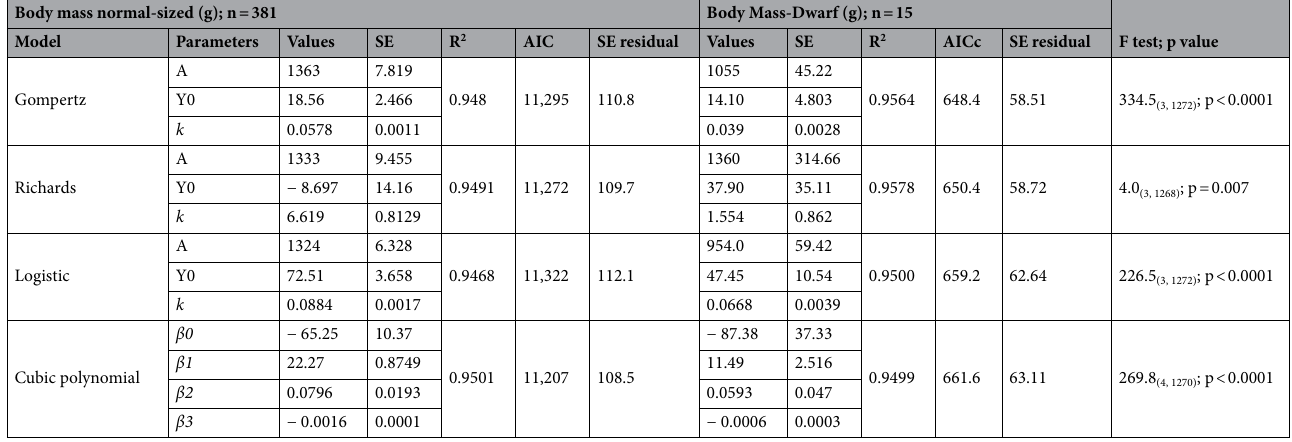
Table 1. Results from four models fitted to body mass growth to normal-sized and dwarfs hyacinth macaw. Parameters of the Gompertz, Richards and Logistic models: A upper asymptote (i.e. predicted adult size), k maximum relative growth rate, Y0 initial value of the asymptotic curve. Cubic polynomial models are represented with four parameters: β0 intercept, β1 maximum relative growth rate, β2 upper asymptote, β3 weight loss